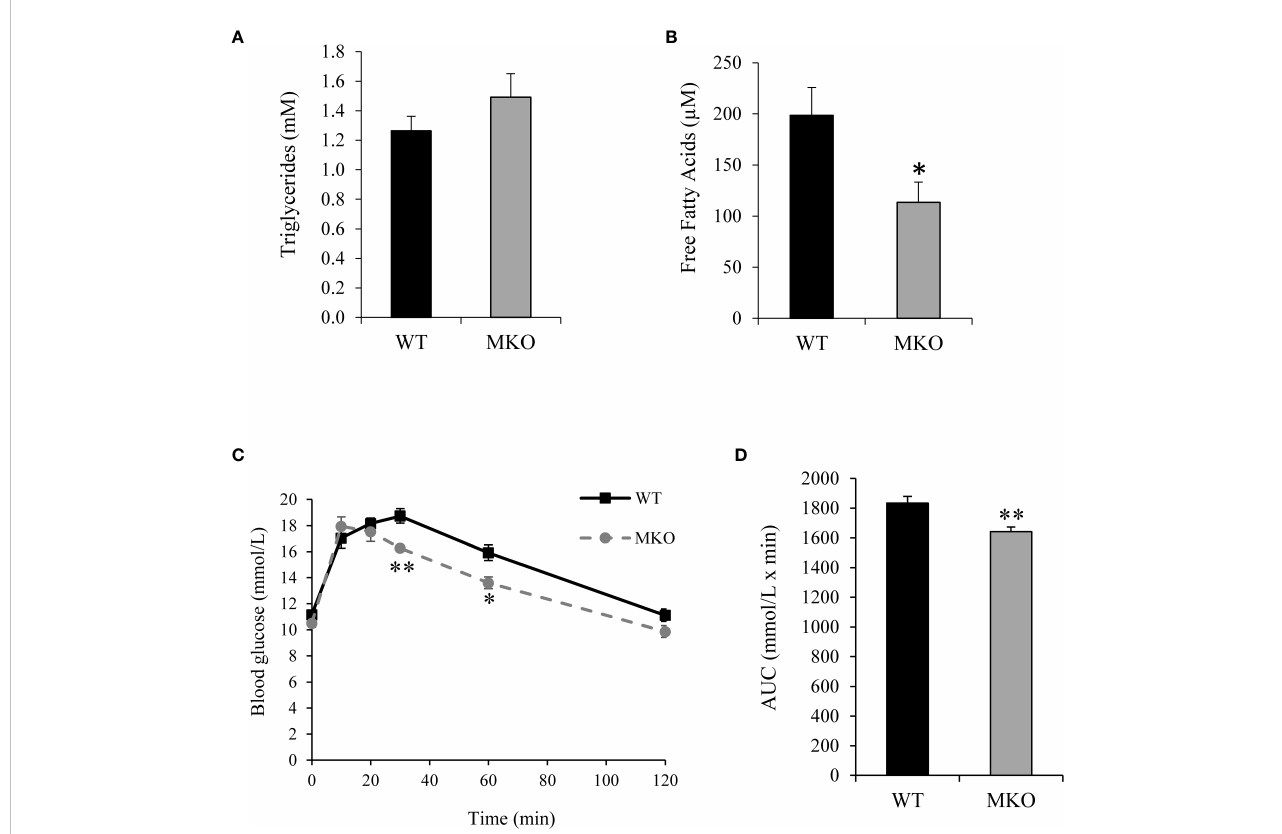
FIGURE 6 Plasma free fatty acid concentration was reduced and blood glucose clearance was increased in Arid5b MKO mice. (A) Triglyceride concentrations (n=8) and (B) free fatty acid concentrations (n=6) were analyzed in plasma from Arid5b WT and MKO mice. Data are presented as the means ± SE. *, p < 0.05. (C) After a 7-8 hour fast, blood glucose was measured at baseline (Time 0) and at the indicated time points after an i.p. injection of glucose. (D) The area under the curve was calculated. (n=6). *, p < 0.05; **, p <